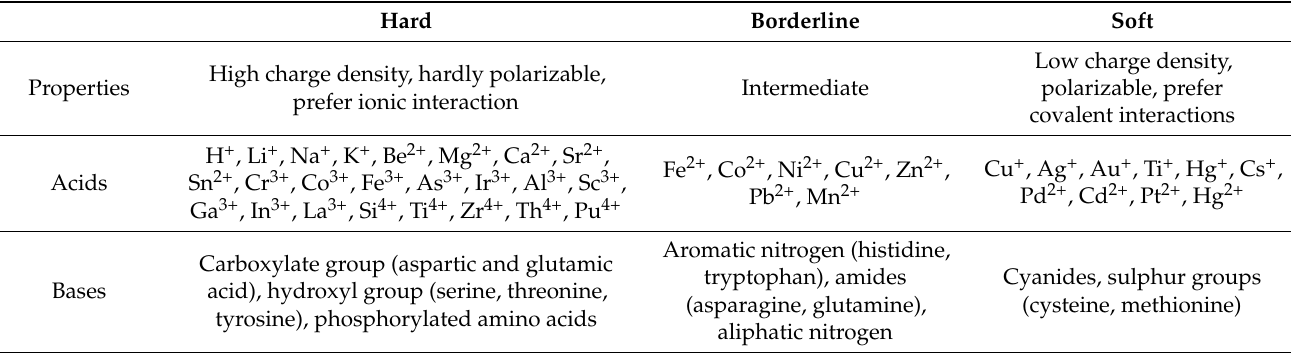
Table 2. HSAB theory adapted from Pearson and